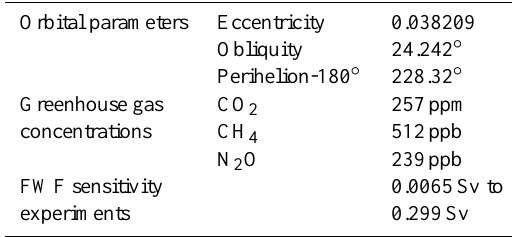
Table 2. Forcing applied to LIG climate simulations. Values are for 130kaBP and in line with PMIP3